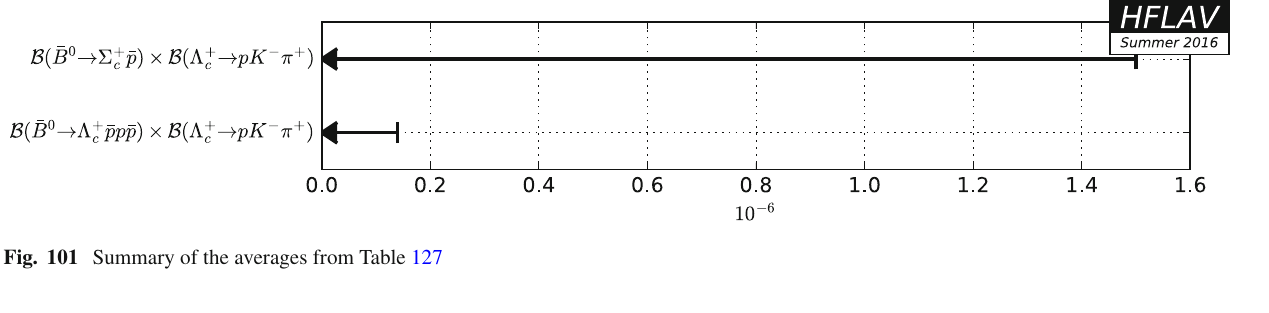
¯ B 0 decays to other ( XY Z ) states are shown in Tables 129, 130, 131, 132, 133, 134 and Figs. 102, 103, 104, 105. Averages of